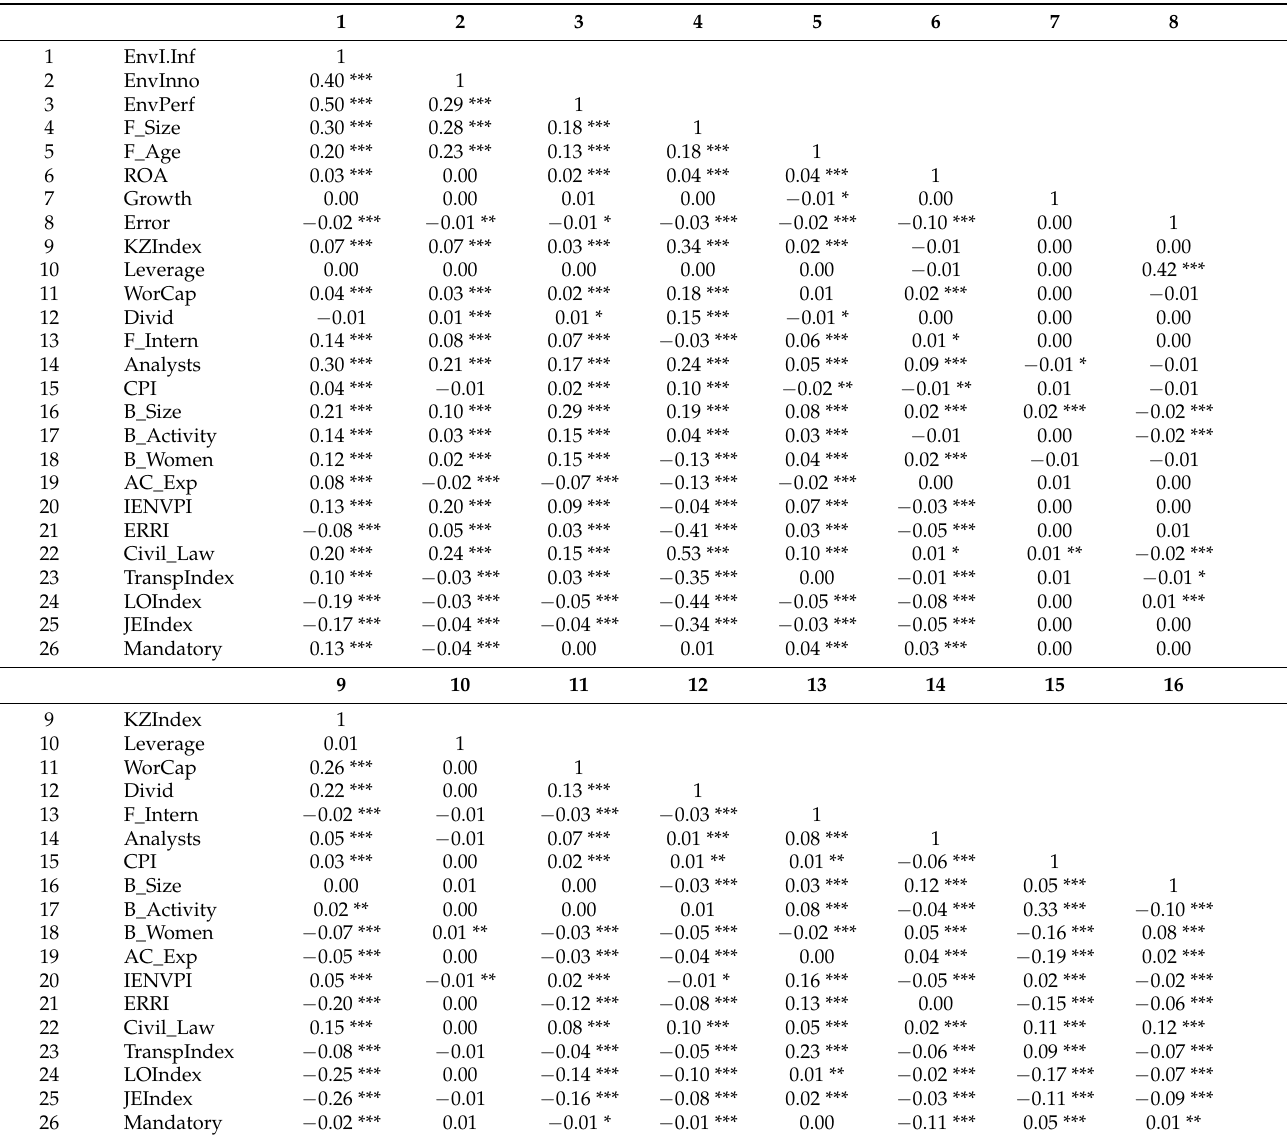
Table 3. Bivariate correlations (*** p < 0.01, ** p < 0.05, * p <